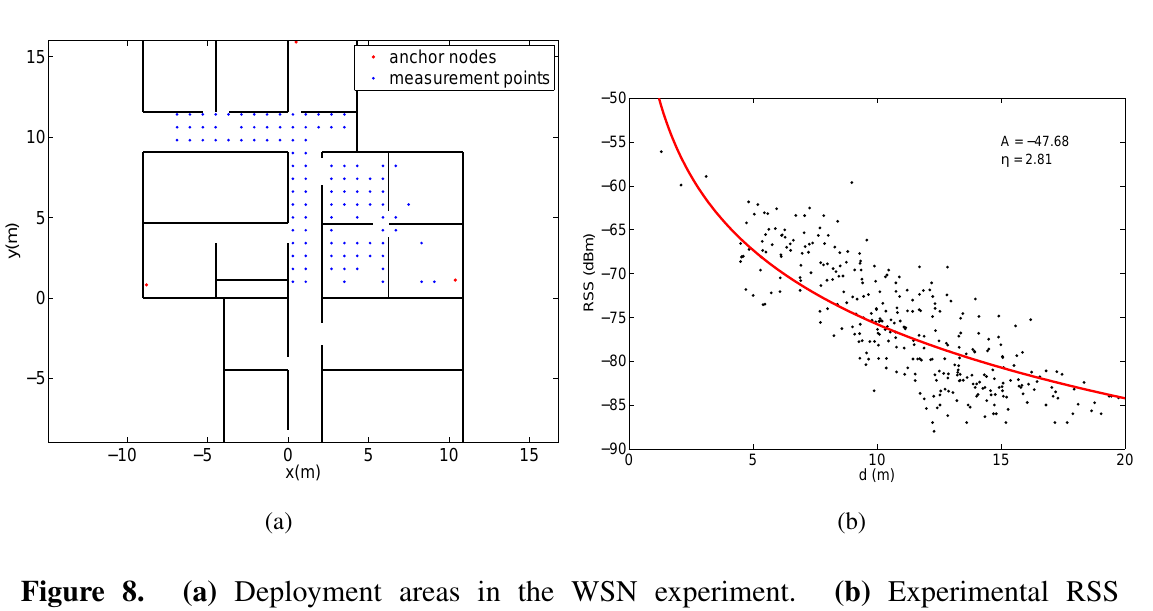
(a) Deployment areas in the Bluetooth experiment. (b) Experimental RSS measurements (107 values) for different distances between the PDA and the Bluetooth access points. The lognormal channel model curve fitting is also represented.